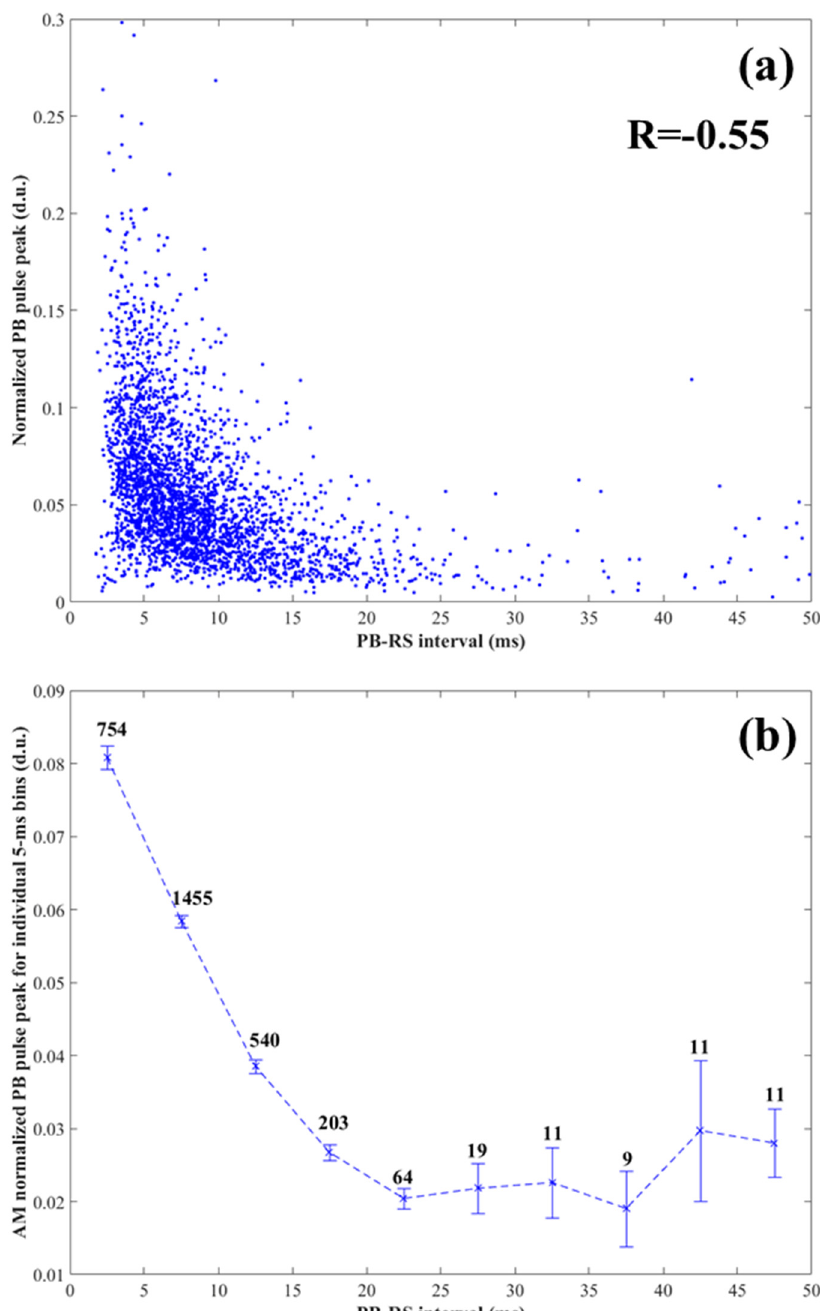
Figure 11. ( a ) Scatterplot of the peak of the largest PB pulse normalized to 100 km (in digitizer units) versus PB-RS interval for the 3077 negative first strokes within 50 to 500 km of LOG. R is the Spearman correlation coefficient; ( b ) AM values of normalized PB pulse peak for individual 5-ms bins versus PB-RS interval. The standard errors in mean values are shown by vertical bars and the corresponding sample sizes are given above them.